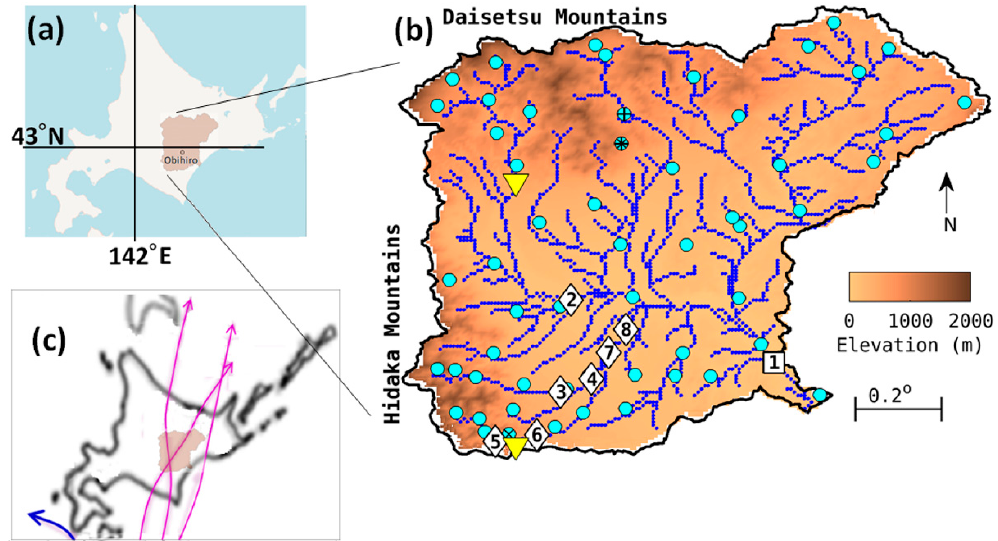
Figure 1. Maps. ( a ) Hokkaido map; ( b ) elevation map of the Tokachi River watershed showing rivers as blue lines; numbered square and diamond marks are the discharge gauges on the main stream and tributaries, respectively (#1: Moiwa, #2: Bisei Bridge, #3: Totta Bridge, #4: Nakajima Bridge, #5: Rrutanjyoryu, #6: Minamisatsunai, #7: Dainiohkawa Bridge, and #8: Nantai Bridge), yellow inversed triangles show dam locations; light blue circles show the locations of rainfall gauges, and the symbols ( ∗ , + , × ) indicate the locations of the Naitai, Nukabira-Gensenkyo, and Satsunai River Dam stations that recorded the large amounts of precipitation as representative data; and ( c ) map of the multiple typhoon traces; pink lines are the preceding three typhoon traces and the blue line is the fourth typhoon trace [4].